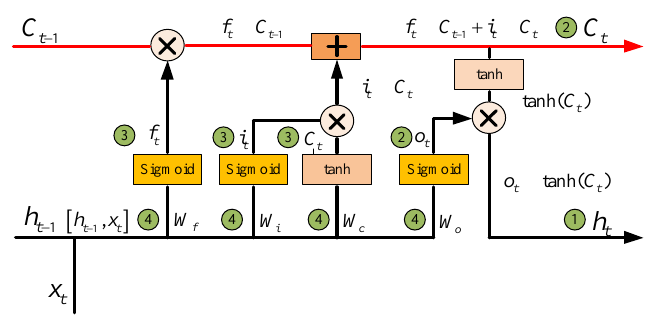
Figure A1. Back-propagation errors of four different stages.